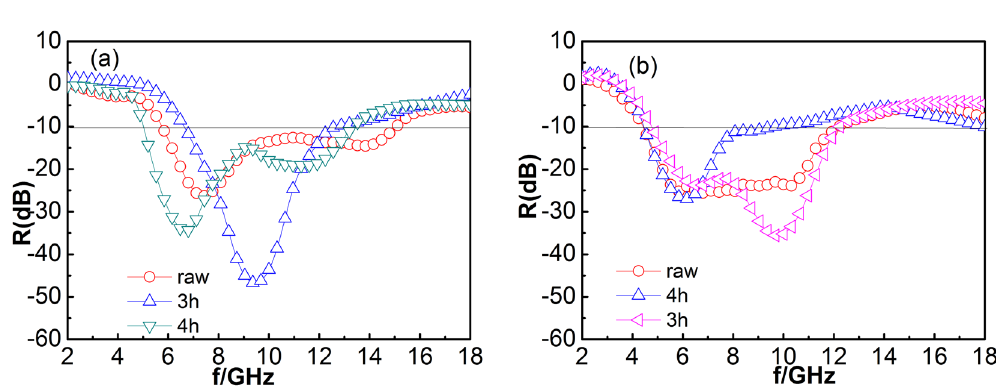
Figure 8. Simulated reflectivity of CNT composites heat-treated for 3 and 4 h at temperatures of 700 °C and 900 °C. The simulated reflectivity of the untreated composites is denoted as 0